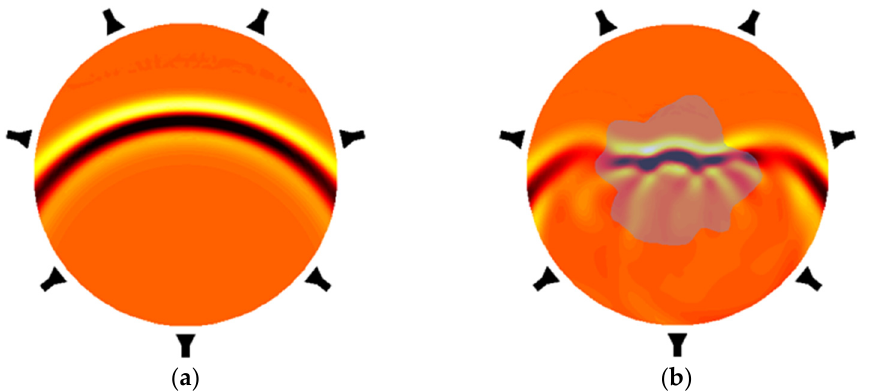
Figure 6. A schematic picture of the microwave propagation inside two different domains with seven antennas around the domain of interest. ( a ) Microwave field without any objects in the domain. ( b ) Microwave field for a scattering object at the center of the domain.